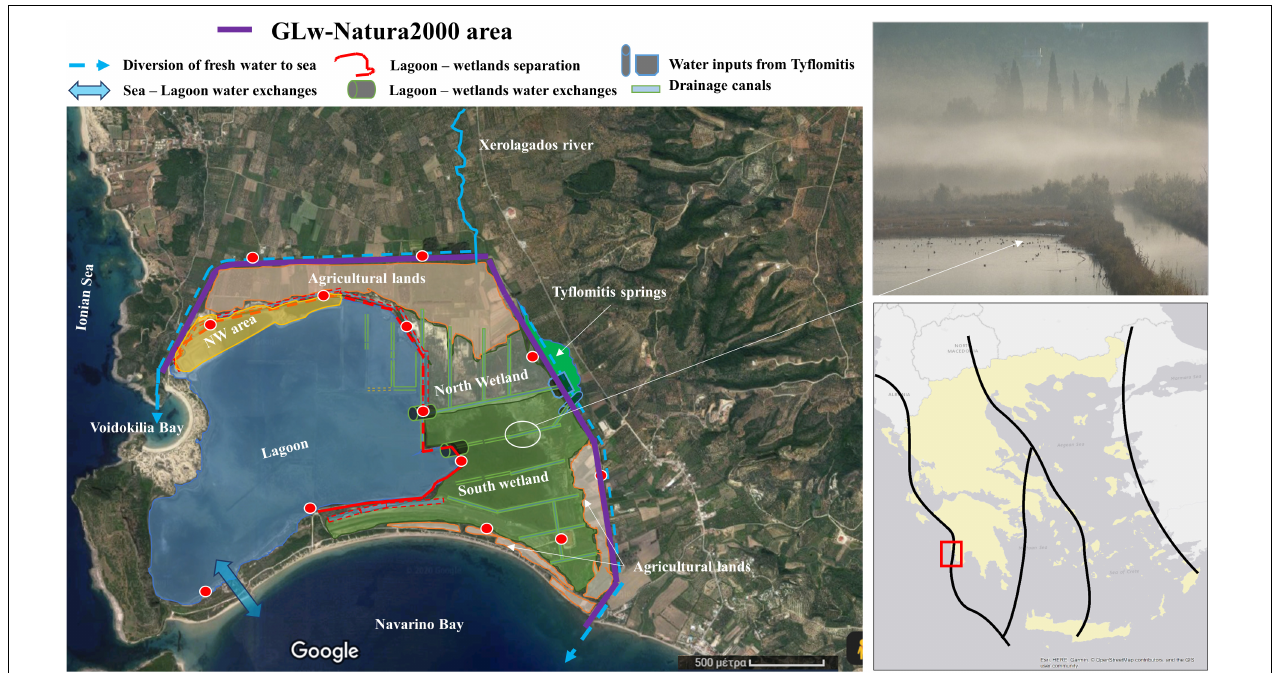
FIGURE 1 | Left side: The map of the study area located in SW Greece (36 ◦ 58 (cid:48) N, 21 ◦ 40 (cid:48) E), showing the different observation points (red dots), and the major sub-areas. It also contains information about the water connections. Right side: Birds’ migration “national” routes in Greece (Hellenic forestry, 2020) along the Mediterranean/Black Sea Flyway (BirdLife International, 2017), and a picture of the site which captures one of the drainage canals in the form that it looks